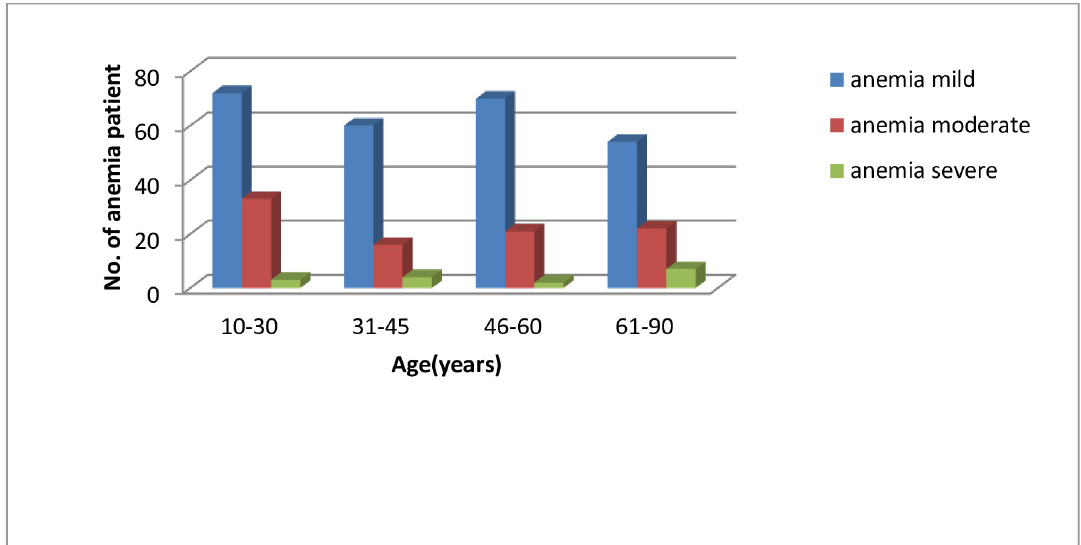
Fig 1. Prevalence of mild, moderate and severe anemia by